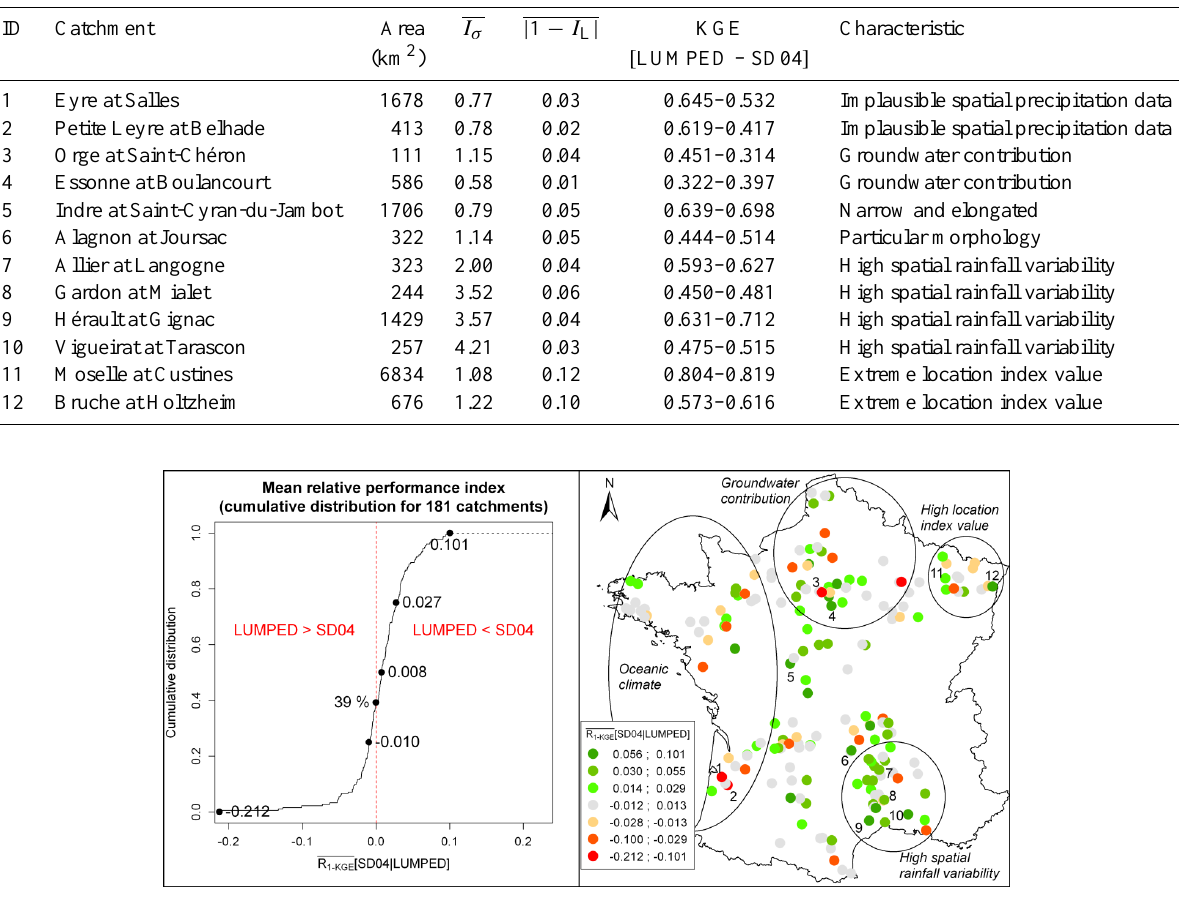
Fig. 13. Relative performance index averaged by catchment: cumulative distribution (left panel); geographic distribution (right panel). The number refers to the particular catchments discussed in Table 4. Green dots ( R 1 − KGE > 0) indicate better performances of the semidistributed